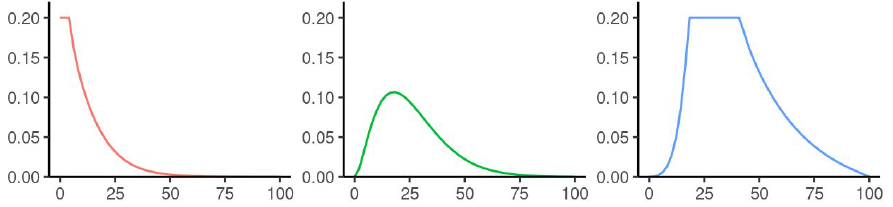
Figure 18. Experiment 3. The structure of the optimal treatment policies u i ( t ) , i = 1,2,3 (responsible